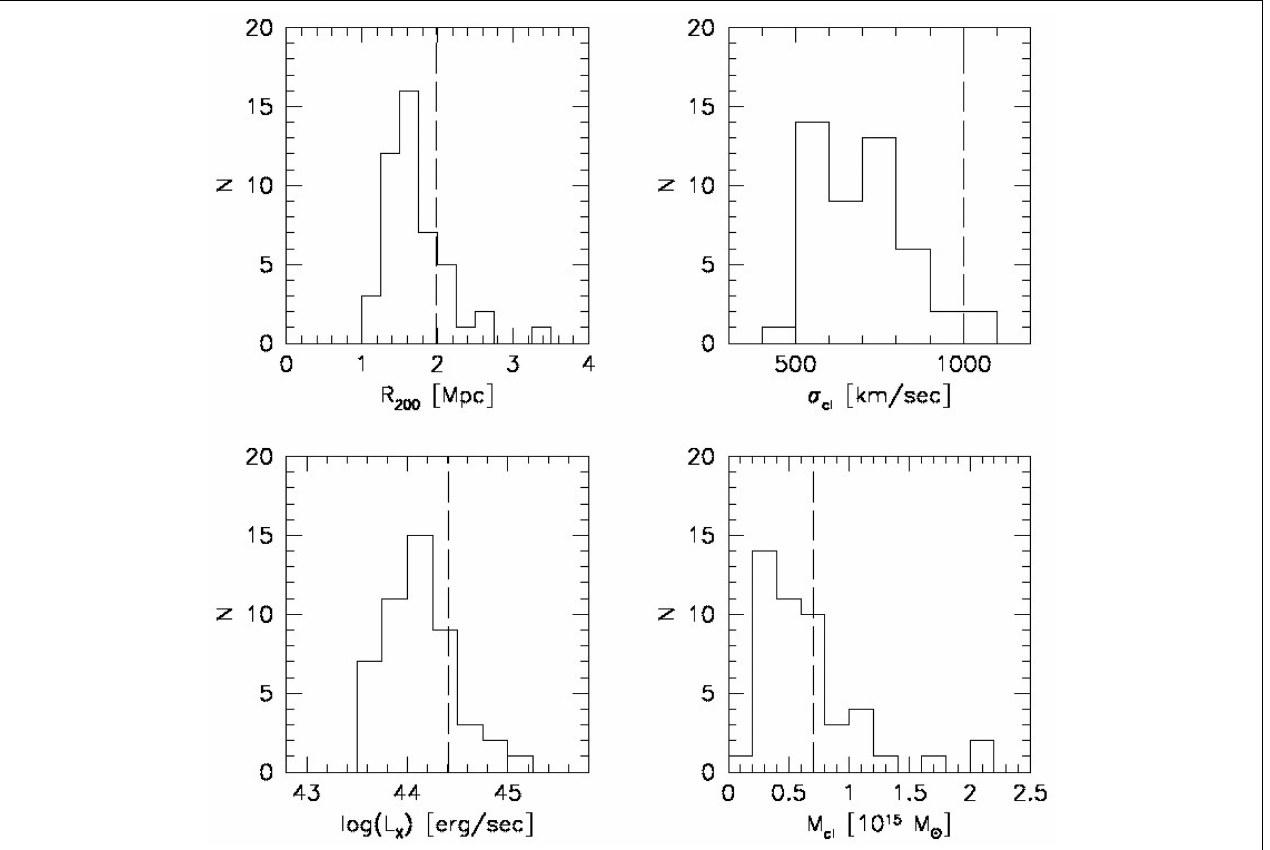
FIGURE 2 | From top left to bottom right we plot here the observed distributions of R 200 , σ cl , log ( L X ) , and M cl for the WINGS clusters that belong to the stacked sample. The dashed line mark the values for the Coma cluster.